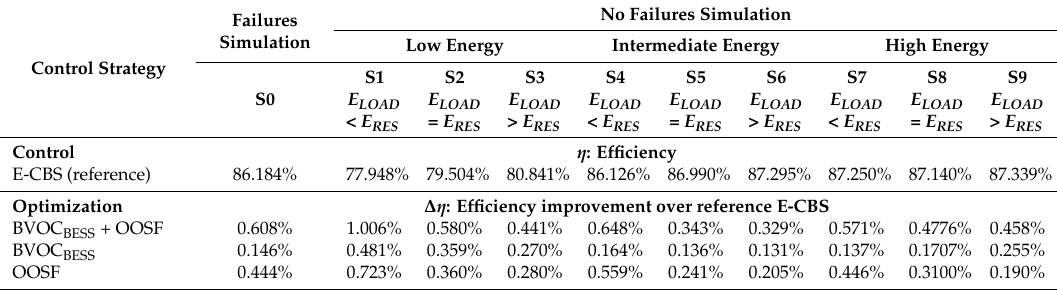
Table 3. MG global efficiency improvement under four different control strategies, in ten different scenarios S0–S9, over seven days operation.